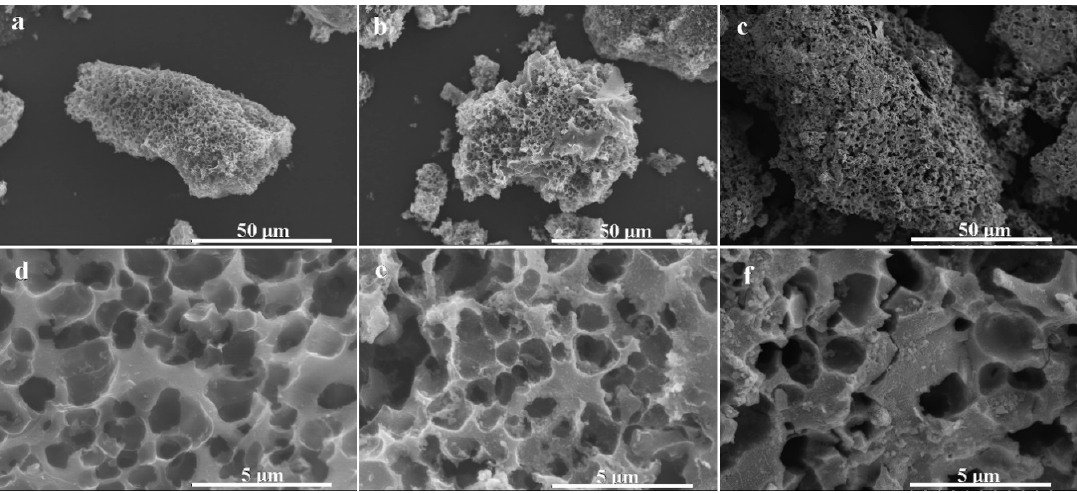
Figure 2. Scanning electron microscopy (SEM) images of ( a , d ) biochar, ( b , e ) biochar/ γ -Fe 2 O 3 , and ( c , f ) biochar/ γ -Fe 2 O 3 @chitosan. ( d – f ) Magnified images at the center of the materials in ( a – c ), respectively.